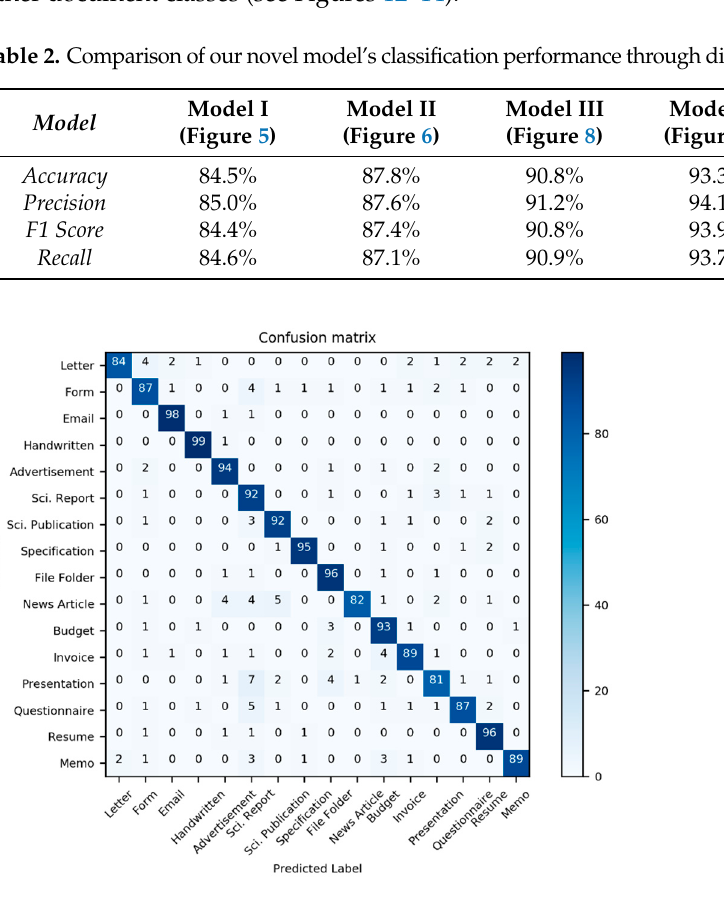
Figure 13. Confusion matrix of the performance results of model IV for 1600 test data from the dataset Haley et al. [59]. (Source: our own images).